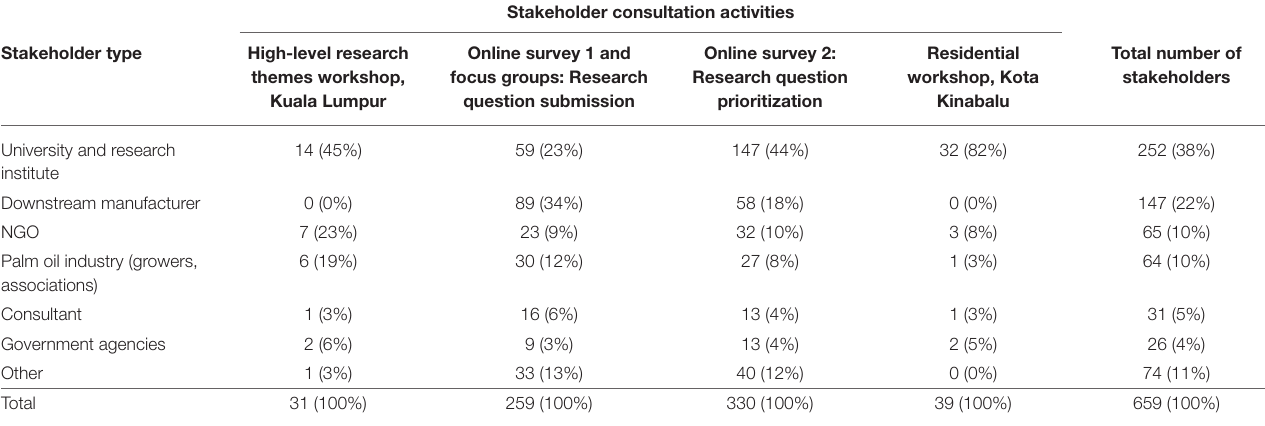
TABLE 2 | Number of participants in the consultation exercises by stakeholder